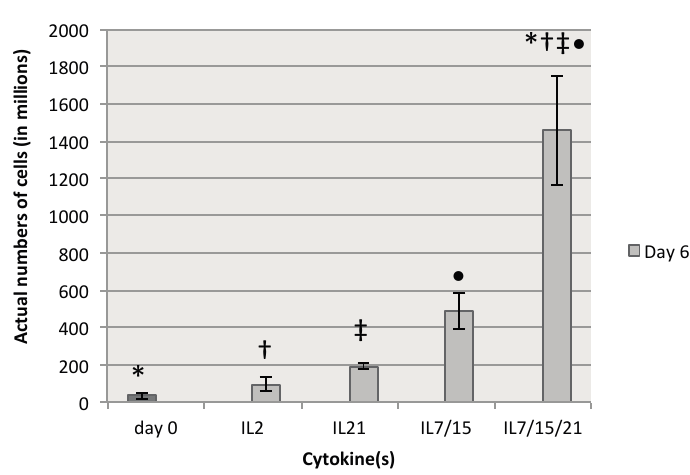
Figure 2. The percentages of CD8+ splenocytes were multiplied by the number of total cells expanded to obtain actual yield of cells in that subset, * ( vs . day 0) = p < 0.0001, † ( vs . IL2) = p < 0.0001, ‡ ( vs . IL21) = p < 0.0001, • ( vs . IL7/15) = p < 0.004. Flow cytometry analysis was also performed for CD8+ T cell subsets for both splenocytes and DLN lymphocytes on day 0 and after 6 days of expansion (Figure 3a). Splenocytes grown in IL-7/15/21 consistently expanded or sustained a higher percentage of CD8+ T central memory (T CM ) cells vs.